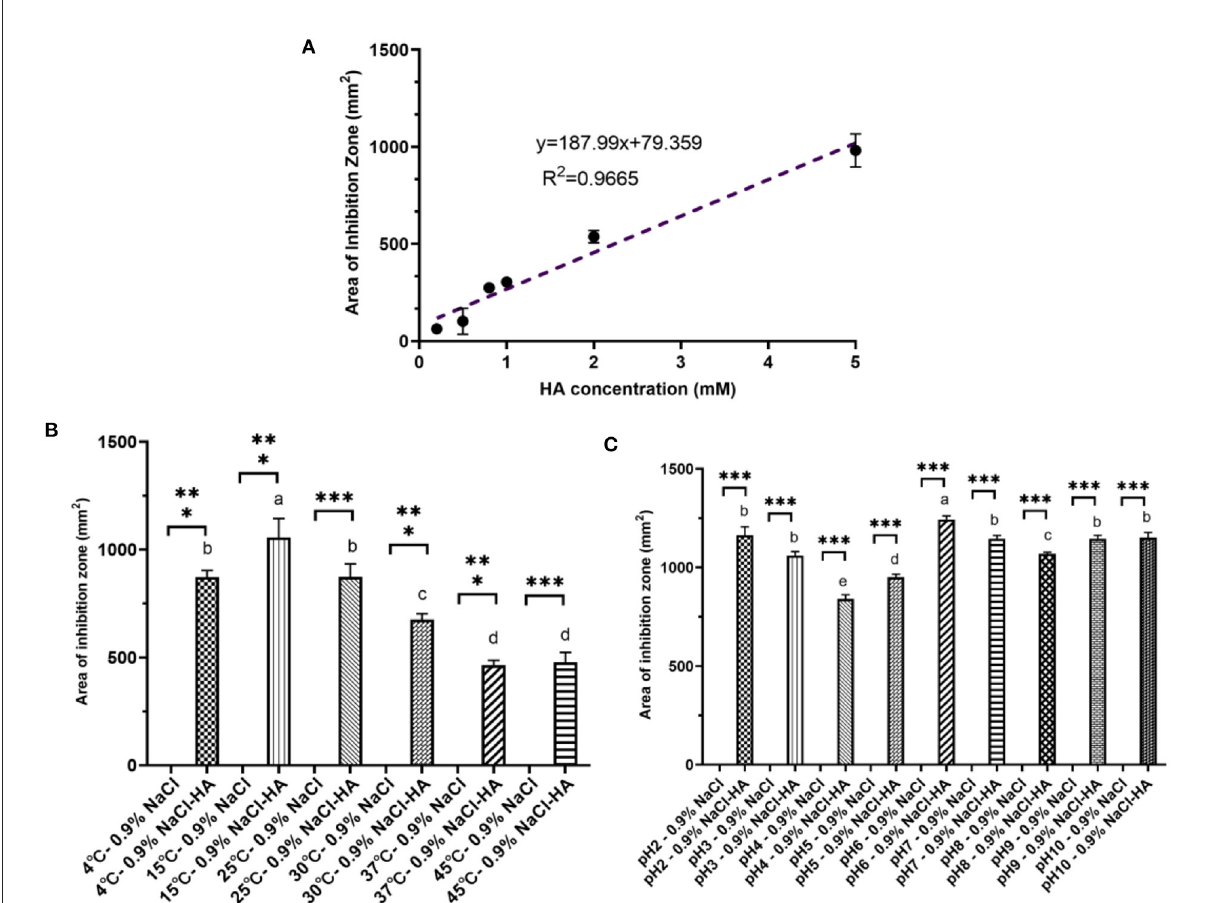
FIGURE2 Characteristic of hydroxylamine inhibition toward B. velezensis V4. (A) Linear dose-dependency of HA-mediated inhibition. (B) The effect of temperature on HA-mediated inhibition. Pairwise comparisons between treatments are shown using a letter-based representation. Different letters indicate distinct significant differences. (C) The influence of pH on HA inhibition. Error bars represent standard deviation based on three replicates. Pairwise comparisons between treatments are shown using a letter-based representation. Different letters indicate distinct significant differences. *** means there is a significant difference between respective control and